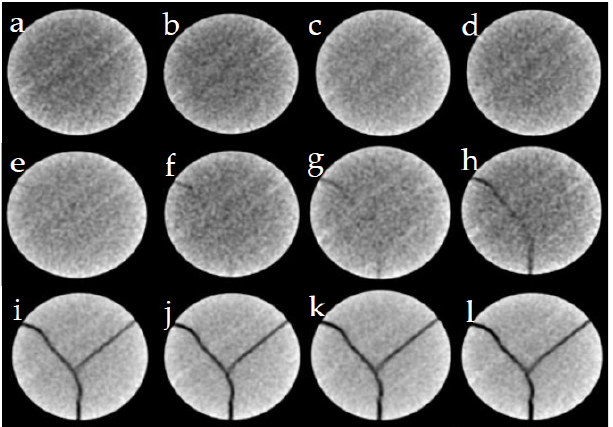
Figure 3. CT image of the first scan section: ( a ) σ = 0.00 MPa; ( b ) σ = 8.14 MPa; ( c ) σ = 10.30 MPa; ( d ) σ = 14.02 MPa; ( e ) σ = 16.71 MPa; ( f ) σ = 18.85 MPa; ( g ) σ = 19.09 MPa; ( h ) σ = 19.93 MPa; ( i ) σ = 20.5 MPa; ( j ) σ = 21.45 MPa; ( k ) σ = 23.05 MPa; ( l ) σ = 25.88 MPa.